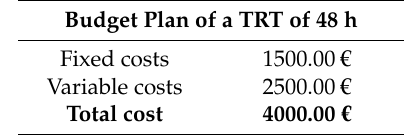
Table 12. Cost of performing a TRT in